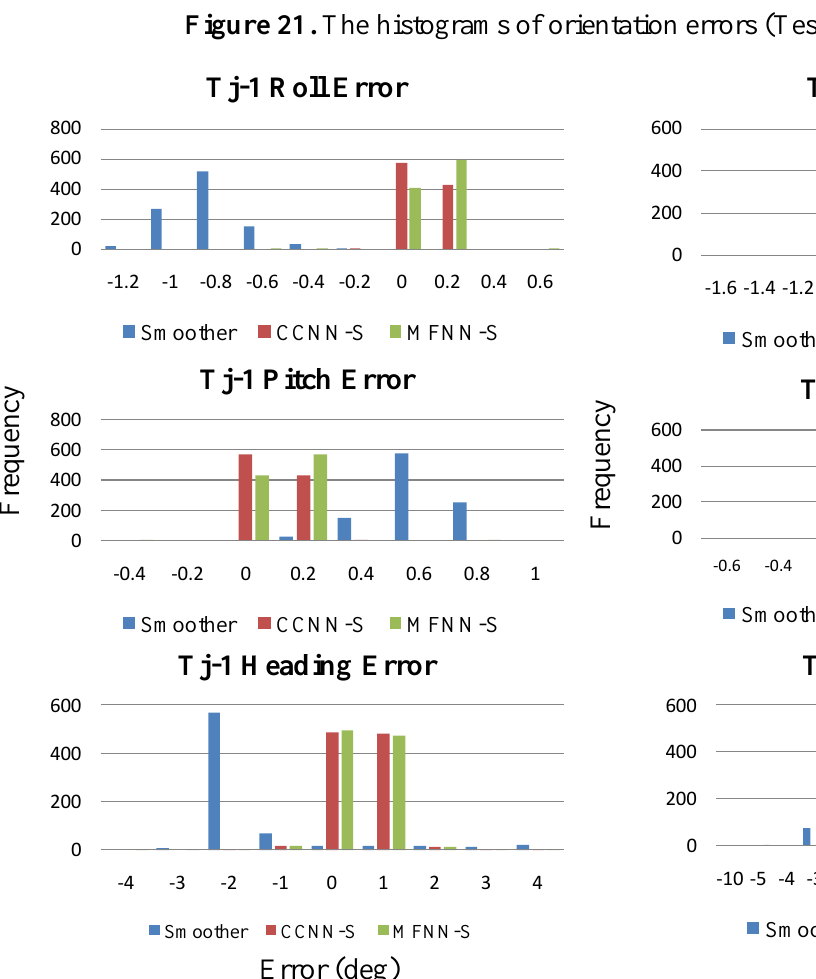
Figure 21. The histograms of orientation errors (Testing